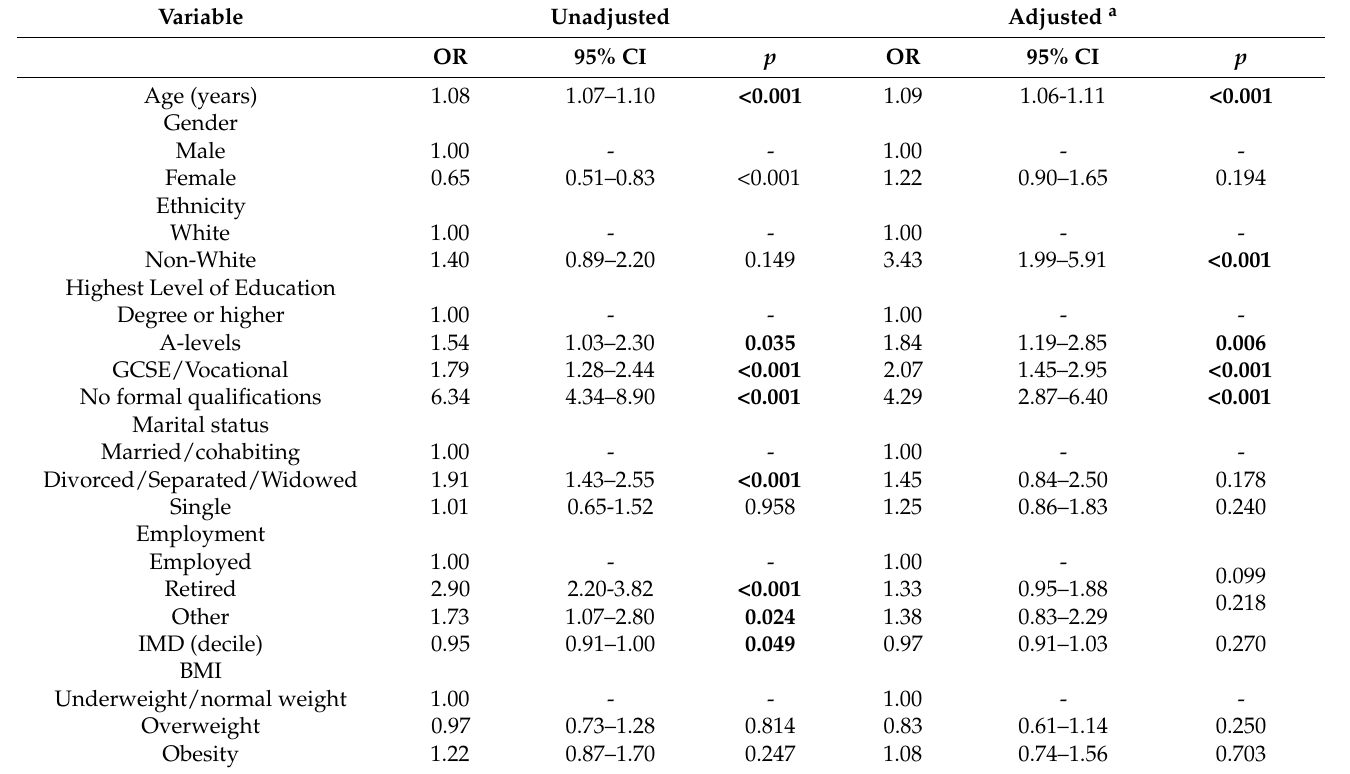
Table 2. Logistic regression analyses for method of completing 24-HR (interviewer-completed 24-HR as target group) ( n =